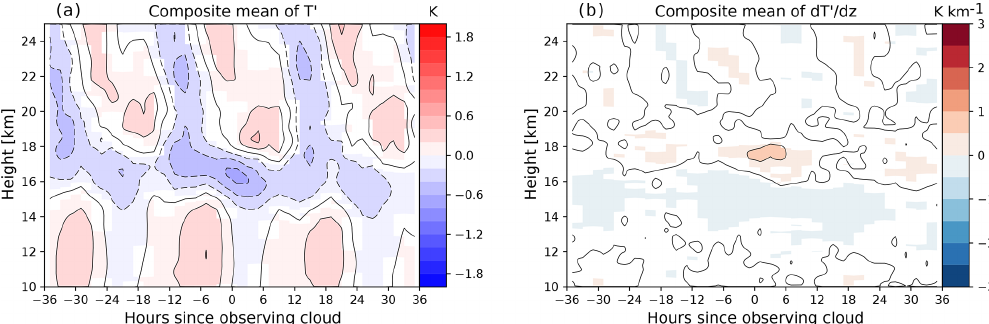
Figure 7. Composites of (a) T (cid:48) and (b) d T (cid:48) / d z based on height above mean sea level (instead of height coordinate relative to cloud top as in Fig. 6). Colored contours are at or above the 95% significance level according to the Student’s t test. Contour levels are identical to Fig.